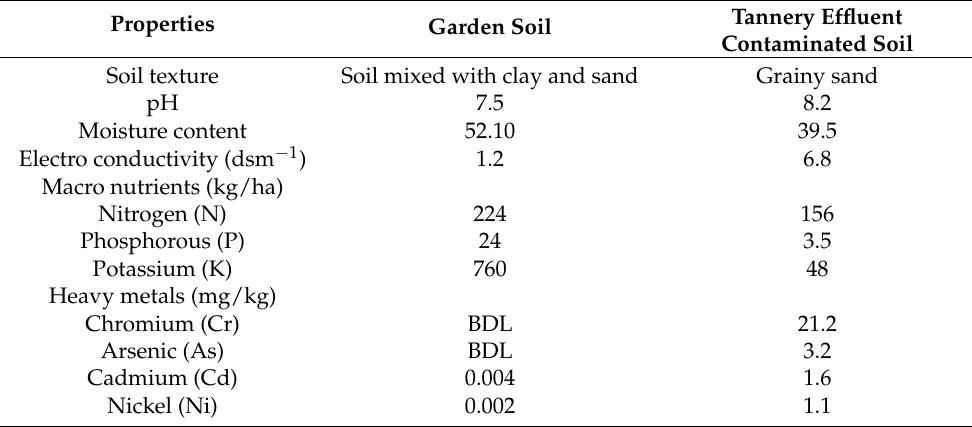
Table 1. Physicochemical properties of the garden and leather industrial effluent contaminated